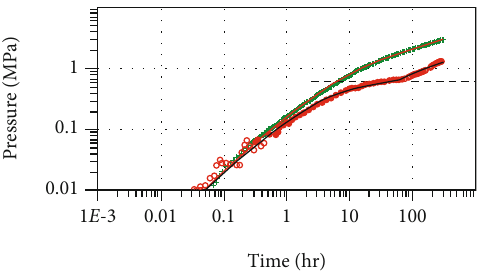
Figure 10: Pressure drop curve characteristics of typical well test, well